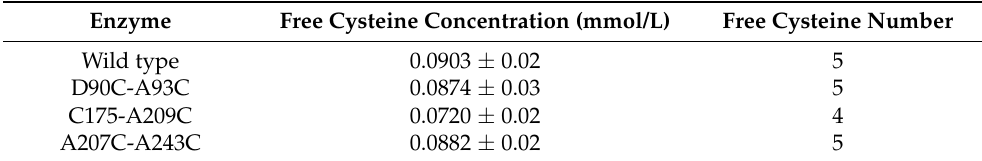
Table 1. Cysteine content of wild-type Cb-DPEase and its mutants. Enzyme Free Cysteine Concentration (mmol/L) Free Cysteine Number Wild type 0.0903 ± 0.02 5 D90C-A93C 0.0874 ± 0.03 5 C175-A209C 0.0720 ± 0.02 4 A207C-A243C 0.0882 ±